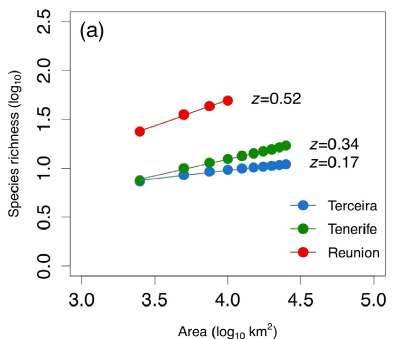
Figure 4. Species–area relationships (SARs) based on species accumulation curves (SACs) in Terceira (Azores), Tenerife (Canaries), and Reunion